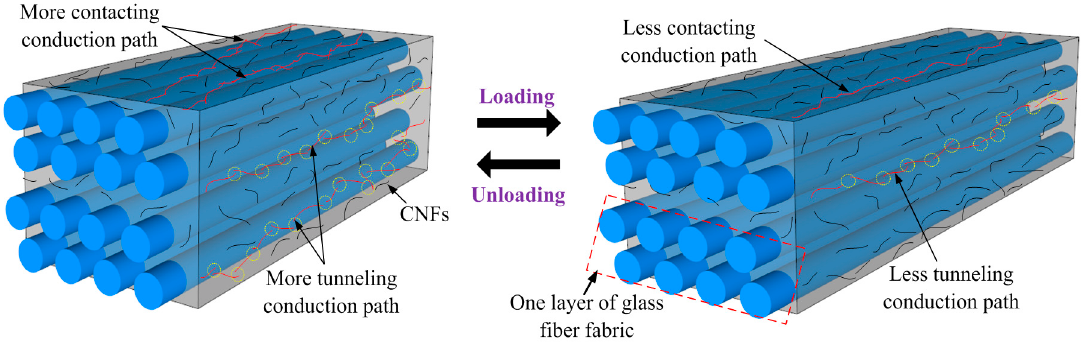
Figure 11. Schematic diagram of the piezoresistive mechanisms of CNF/GFRP laminates.